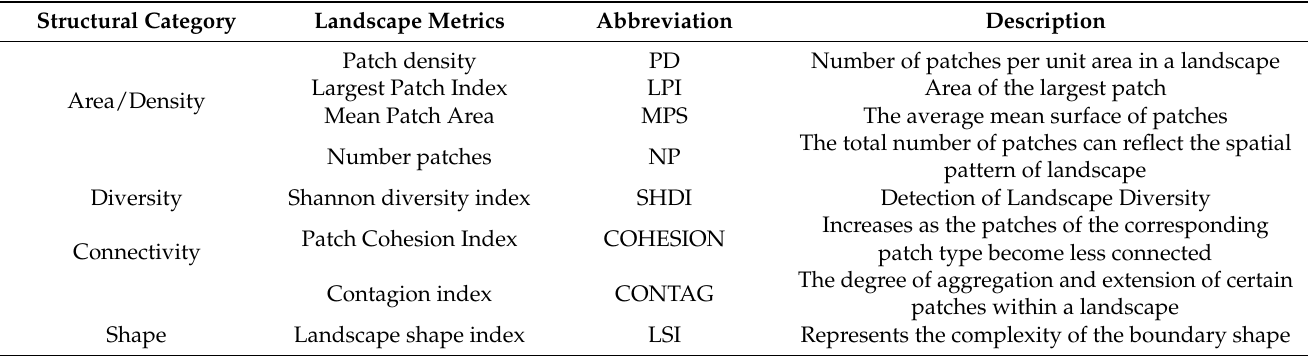
Table 2. Description of landscape metrics.